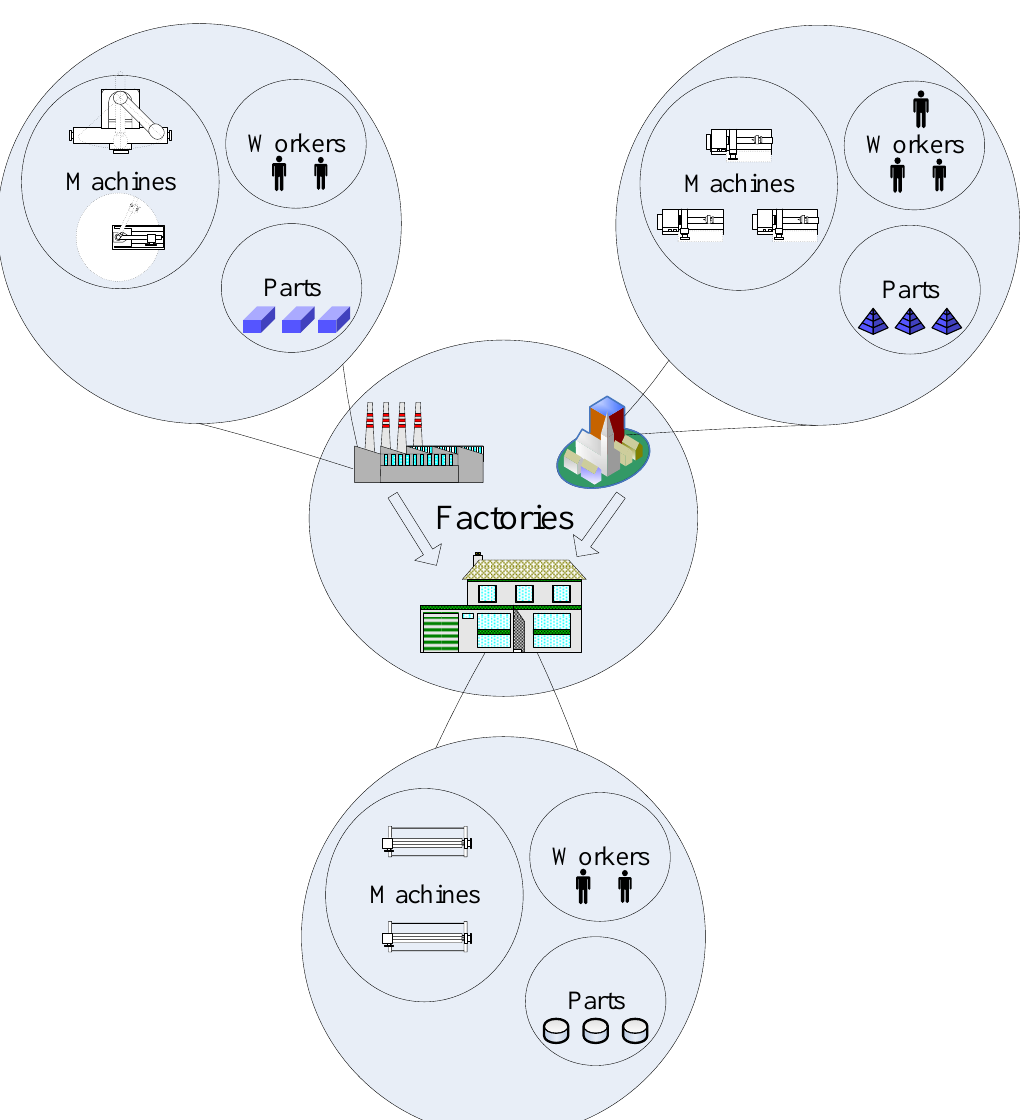
Figure 1. Entities in Internet of Things (IoT)-enabled Manufacturing Environment. The Cyber World of RMS in Figure 2 consists of the several types of agents, including task agent, resource agents, process agents and context generation agents. All these agents interact with each other by applying some negotiation protocol provided by the MAS platform. Operations of RMS are driven by a goal, usually specified by an order. A task agent aims to achieve the goal of production according to the order received. A process agent denotes the production process, usually specified by a process (workflow) model. A process (workflow) model is used to describe the operations to be performed on a task and the precedence constraints of these operations. A resource agent represents a resource such as a machine or a robot in RMS. A resource model is used to describe the types of activities (operations) supported by a resource agent. The role of a context generation agent is to generate context-aware information to guide resources and workers in